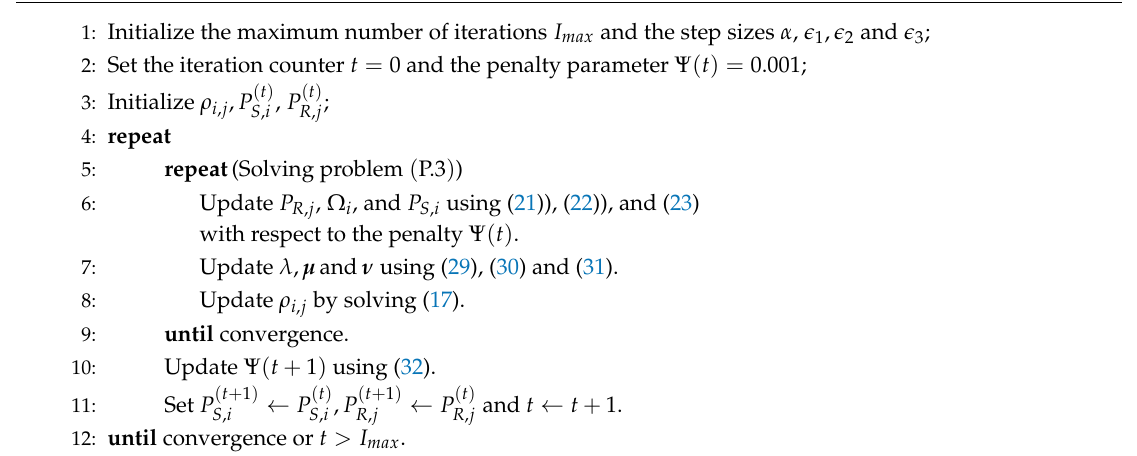
Algorithm 1: Iterative EEM